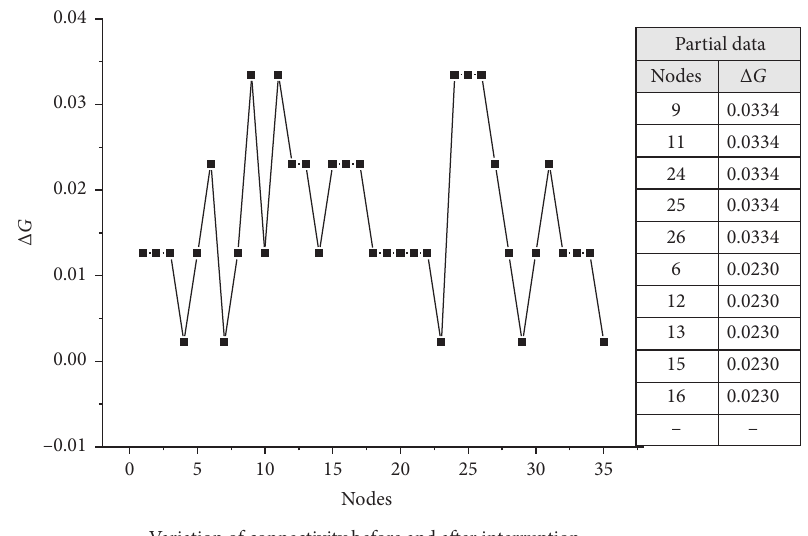
Figure 5: Changes of the connectivity of network before and after